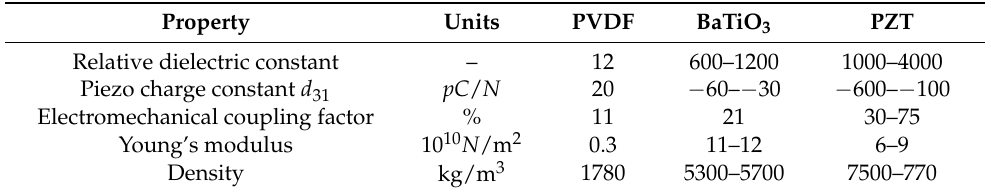
Table 2. Properties of commonly used piezoelectric materials. PVDF–Polyvinylidene difluoride, BaTiO 3 –Barium titanate, PZT–Lead zirconate